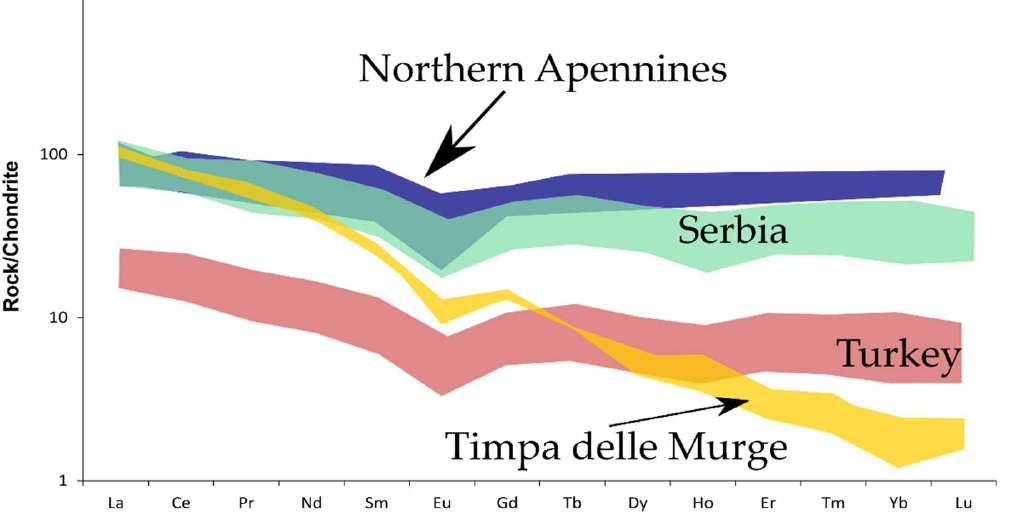
Figure 9. Chondrite normalized REEs patterns of leucocratic rocks of Timpa delle Murge and other Tethyan plagiogranites. Normalization was undertaken with respect to values by McDonough et al. [60].